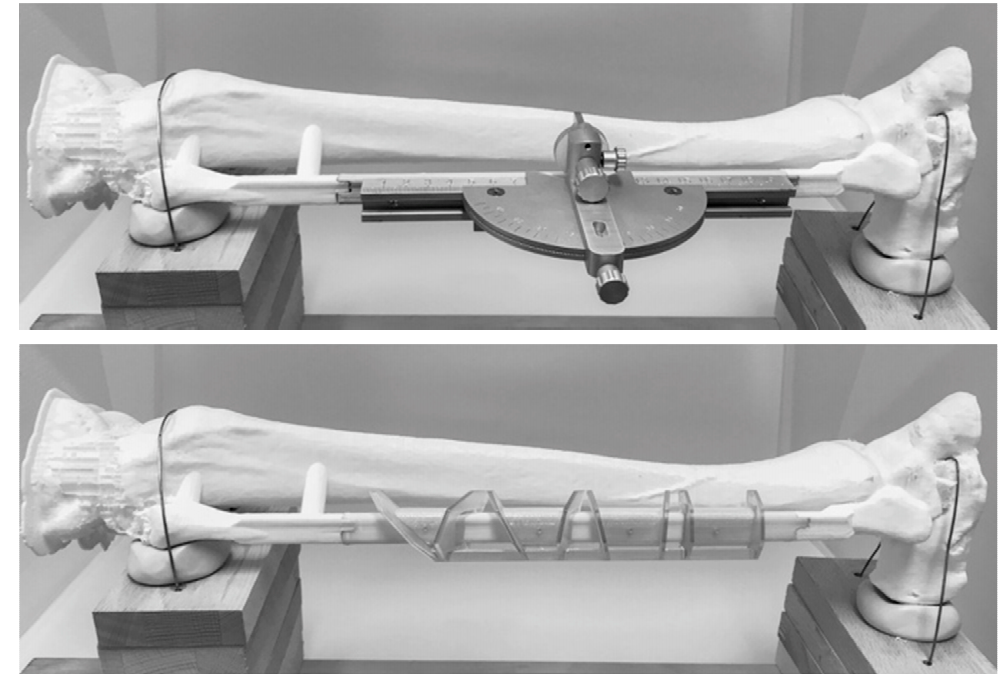
Figure 3. Study setup with the MUC-JIG ( top ) and the 3D-printed cutting guide ( bottom ).